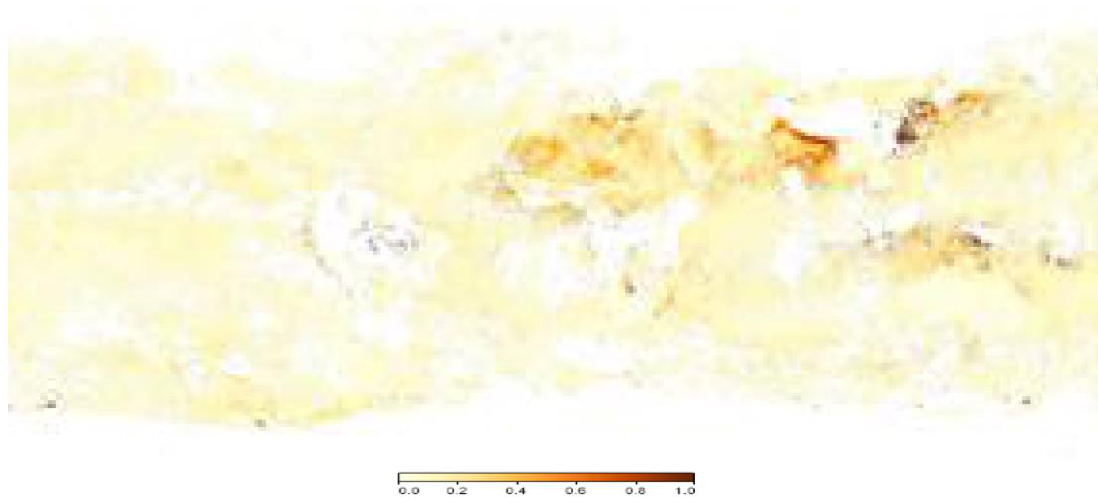
Figure 1. Global AOT concentration.